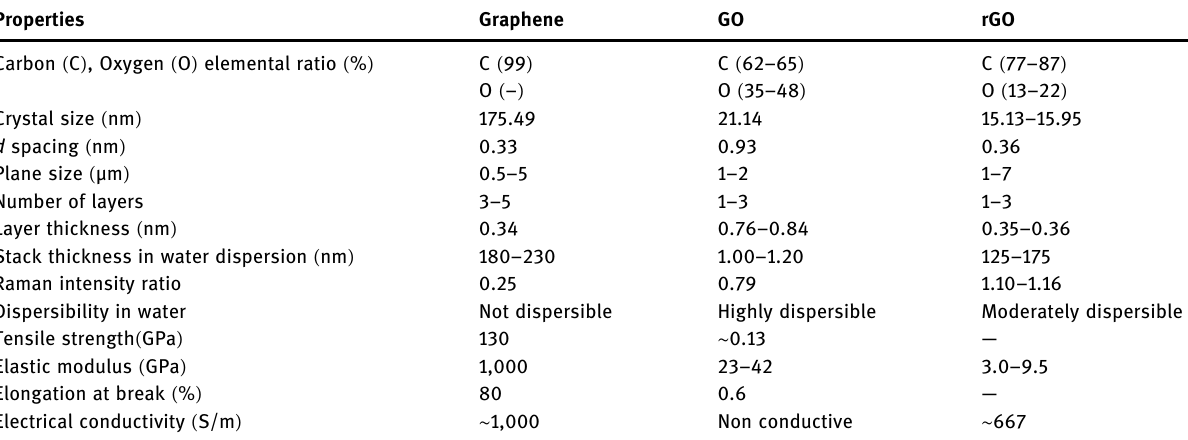
Table 1: Physical, mechanical, and electrical properties of graphene Properties